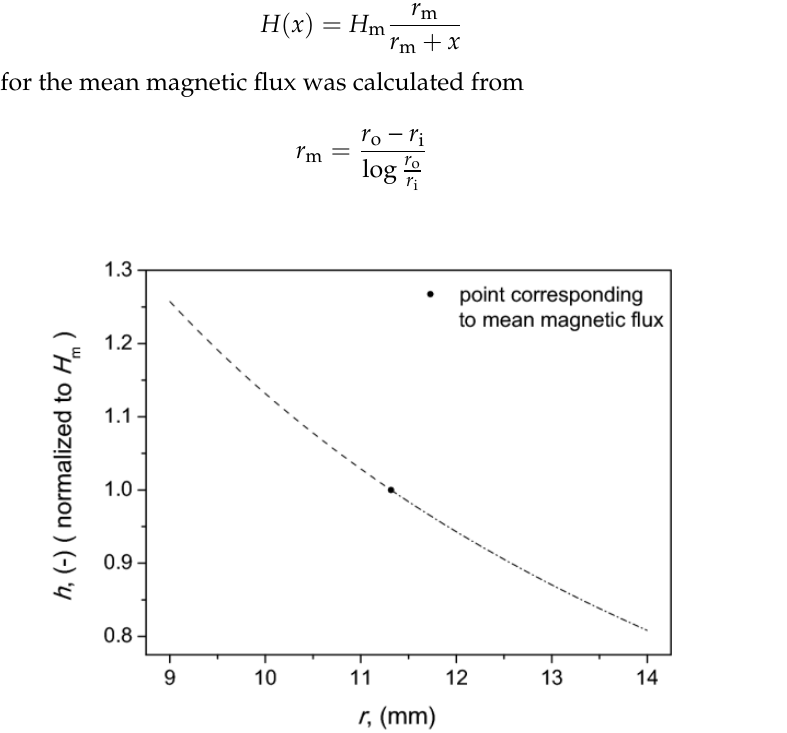
Figure4. Figure 4. Calculated distribution of field strength in the radial direction for the considered core geometry.